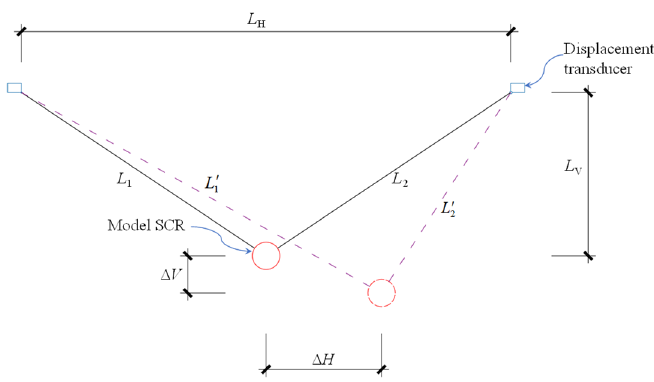
Figure 22. Calculation of the vertical and horizontal displacement.